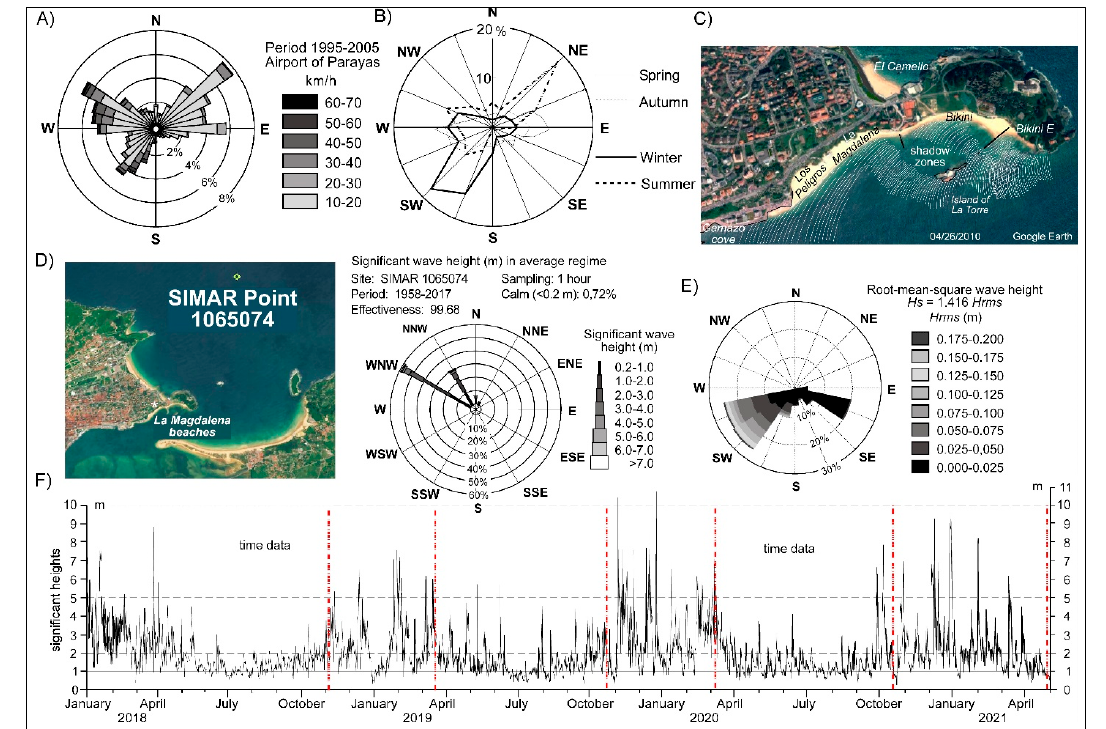
Figure 2. ( A , B ) Average directions and velocities (m/s) of winds at Santander Airport [28]. ( C ) More frequent wave refraction (lines represent swell wave crests) along the beaches. ( D ) Situation of SIMAR Point: 1065074 used in calculations [46]. ( E ) The wave rose was calculated at the end of the spit of Somo [47]. ( F ) Time series of mean significant wave heights (Hs) recorded from January 2018 to May 2021 (Puertos del Estado, Spain; https://www.puertos.es/es-es/oceanografia/Paginas/portus.aspx (accessed on 20 October 2022). The vertical lines in red correspond with measurement surveys.